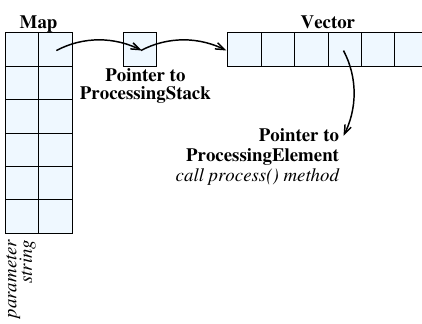
Figure 6. Internal structure of the